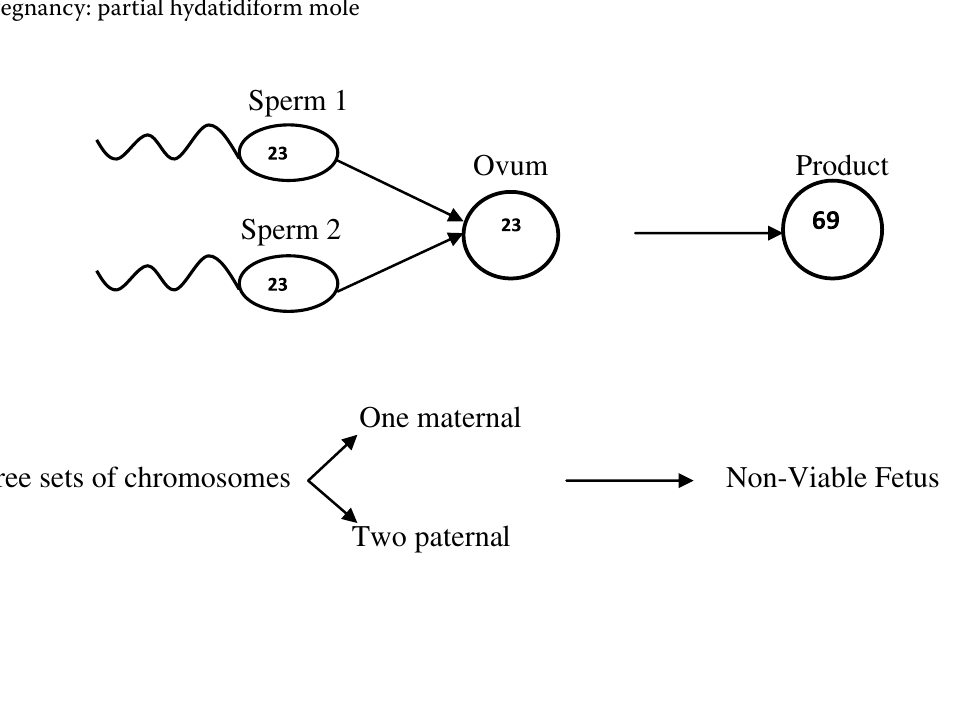
Molar pregnancy: partial hydatidiform mole